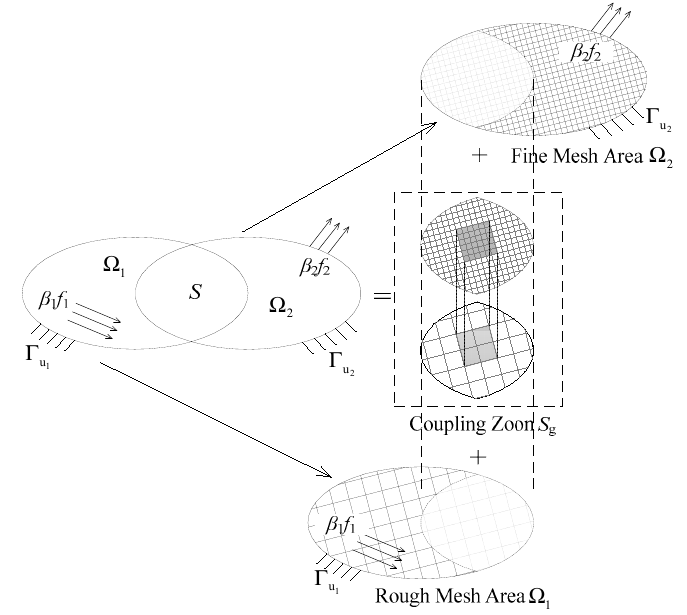
Figure 2. Regional division for Arlequin method.